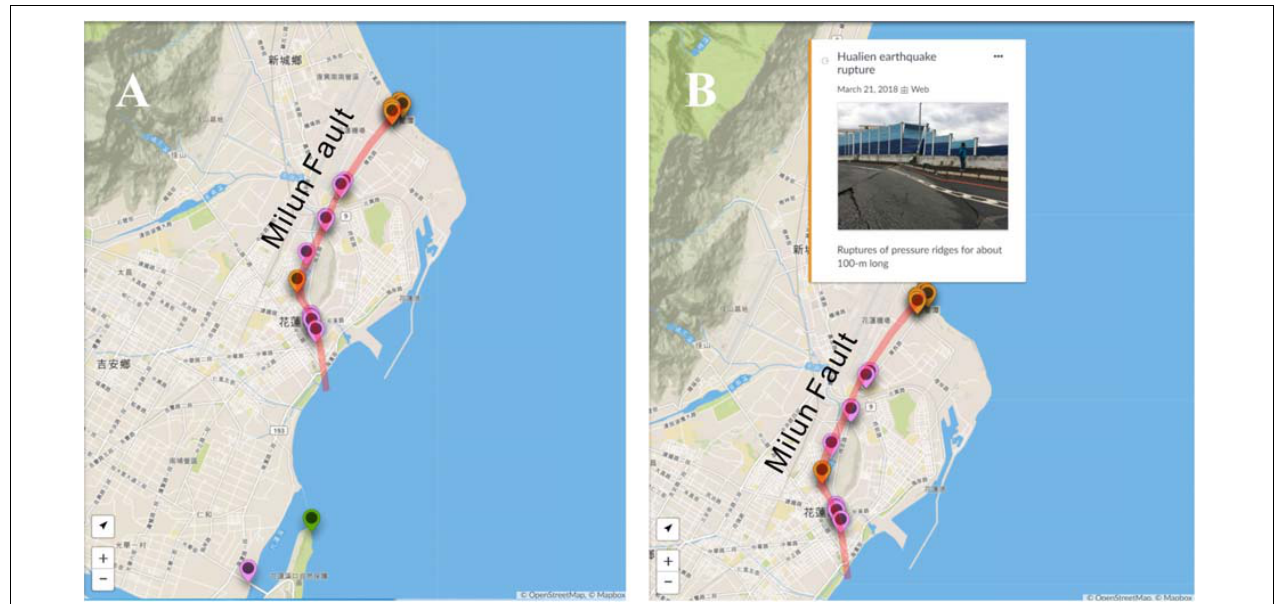
FIGURE 6 | A case study of eyewitness reports during the 2018 Mw 6.4 offshore Hualien earthquake sequence. (A) Among 19 reports, a large portion of the damages collectively marked an arc-shape surface trace, which agrees with the previously identified and mapped Milun fault. We can also find two reports located farther south, indicating other damages existed outside of the Milun fault. (B) A report revealing collapse and offset of the Qixingtan bridge floor close to the northern end of Milun fault.